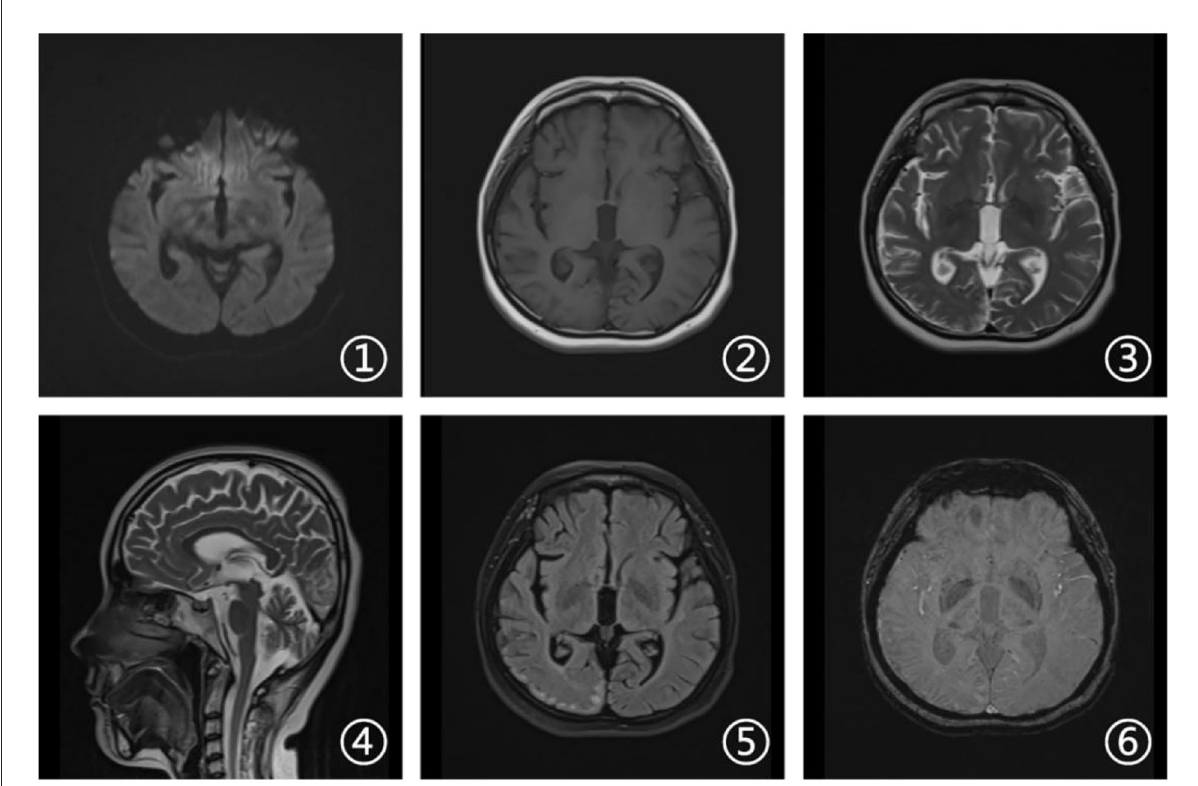
FIGURE2 Brain magnetic resonance imaging (MRI). Axial diffusion-weighted imaging (DWI), T1-weighted, and susceptibility-weighted imaging (SWI) sequences (1, 2, and 6) revealed no other abnormalities. Axial T2-weighted and fluid attenuated inversion recovery (FLAIR) sequences (3 and 5) showed a right occipital cortical hyperintense signal. Sagittal T2-weighted scan (4) showed global brain atrophy and ventricular enlargement with occipital cortical hyperintense